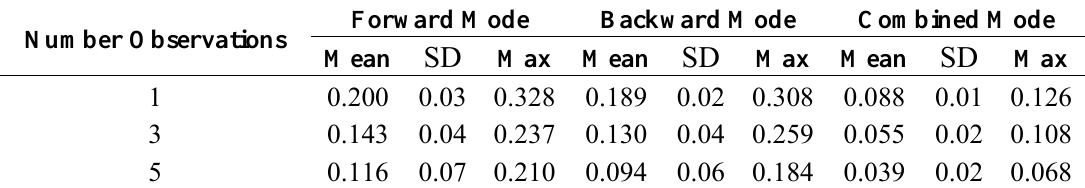
Table 5. Mozambique site. Summary statistics: temporal sequence level mean normalized residuals (mean), standard deviation (SD) and maximum image-level residuals (Max) calculated from all temporal sequences generated with the same number of Landsat observations in Monte Carlo simulations. Residuals are presented for forward, backward and combined mode recursions.